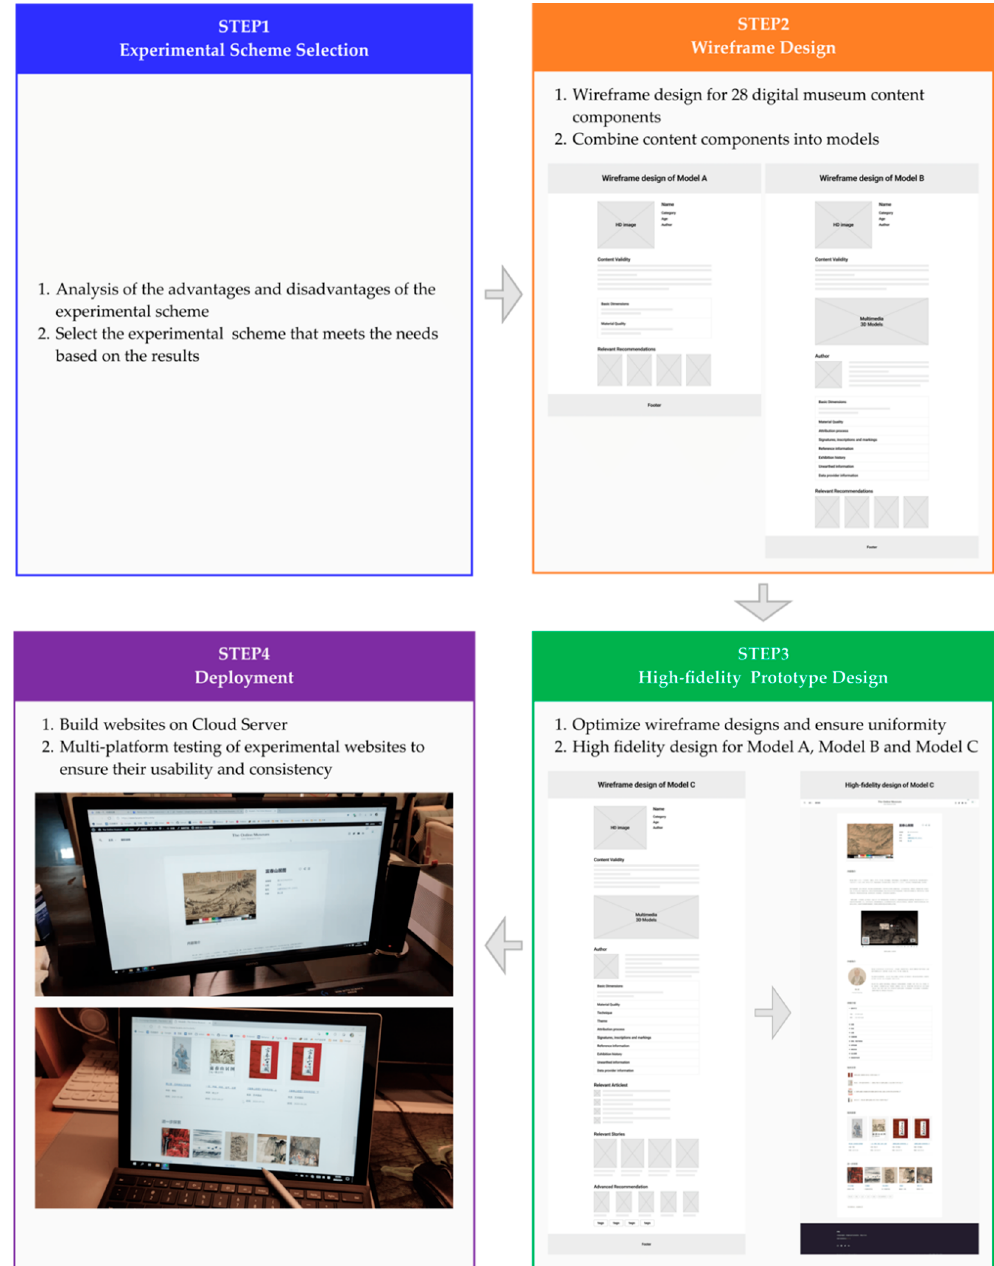
Figure 3. The design and implementation process.